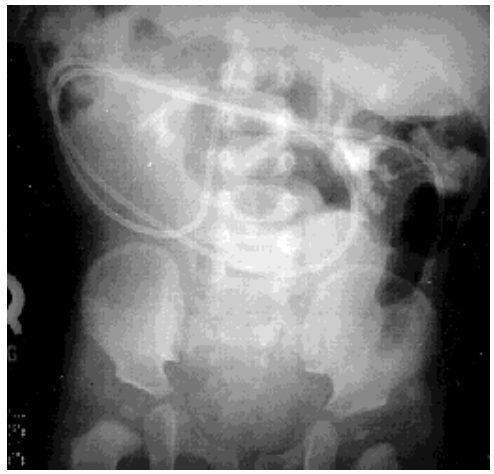
FIGURE 1a . Bilateral staghorn calculi. Conventional abdominal radiograph demonstrates a left complete and a right partial staghorn calculi. VP shunt is noted.